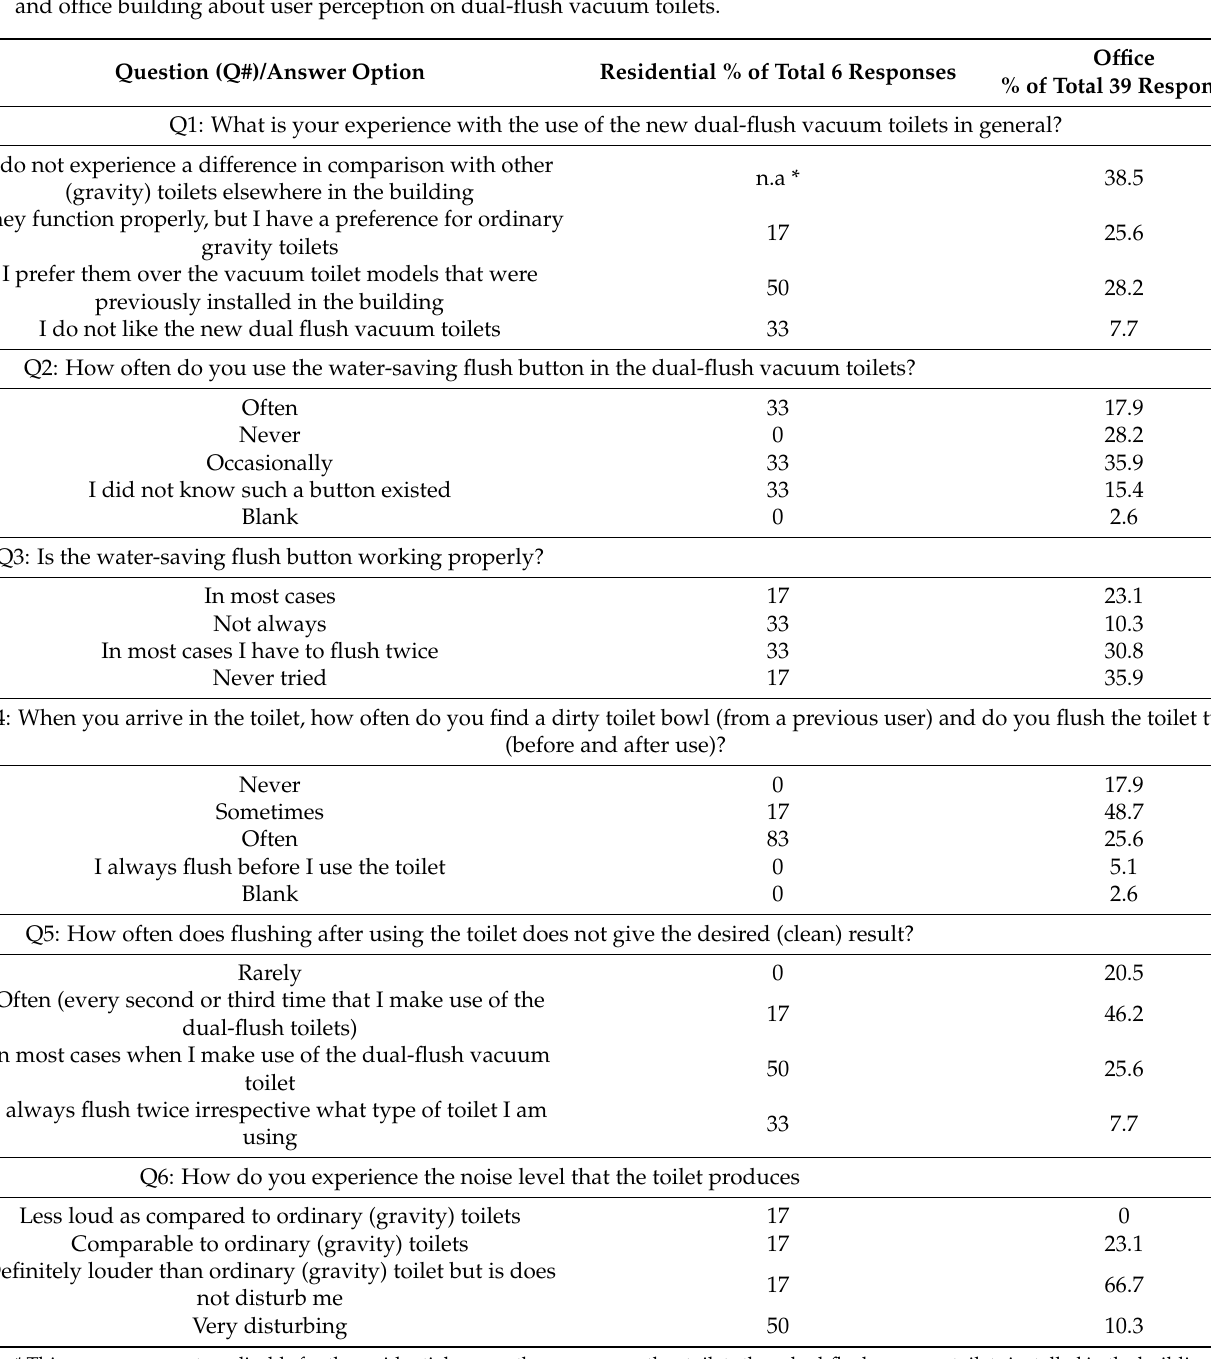
Table 1. Questions, answer options and summary of results of the multiple-choice survey performed at the residential area and office building about user perception on dual-flush vacuum